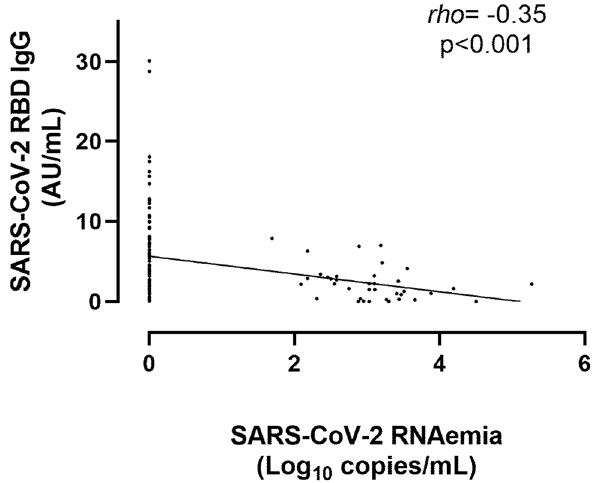
Figure 4. Overall correlation between anti-SARS-CoV-2-S (RBD) antibody and SARS-CoV-2 RNA levels in plasma. Rho and P values are shown.